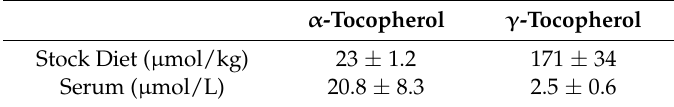
Table 1. Tocopherol Concentrations (mean ± SD) in Monkey Stock Diet * and Serum ( n = 7). α -Tocopherol